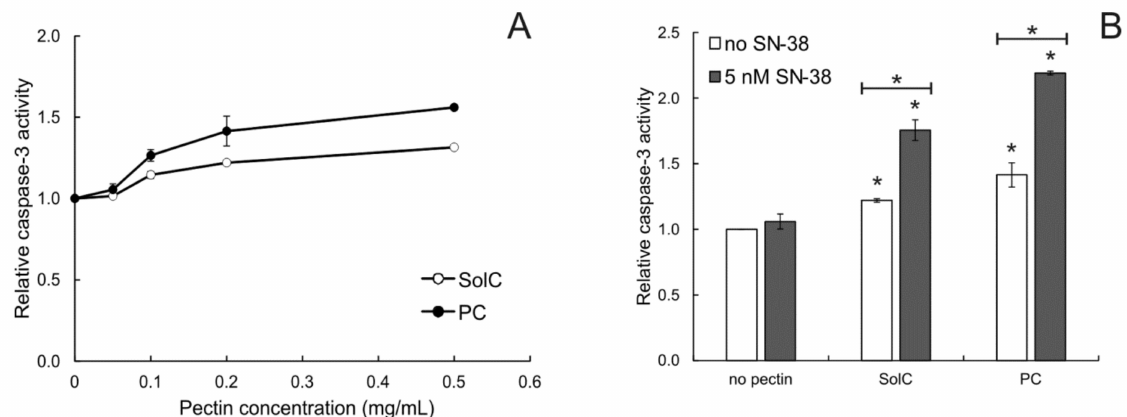
Figure 3. Relative caspase-3 activity in HCT 116 cells treated with pectins ( A ) and 0.2 mg/mL pectins in combination with SN-38. ( B ) for 48 h. The means of three experiments ± SD are presented (* p < 0.05). Statistical significance was checked between the studied probes and controls (no pectin), and between probes containing only pectin and pectin combined with SN-38. In panel A only the measurements for 0.05 mg/mL of SolC and PC were not significantly different from the control (not marked on the graph for the sake of